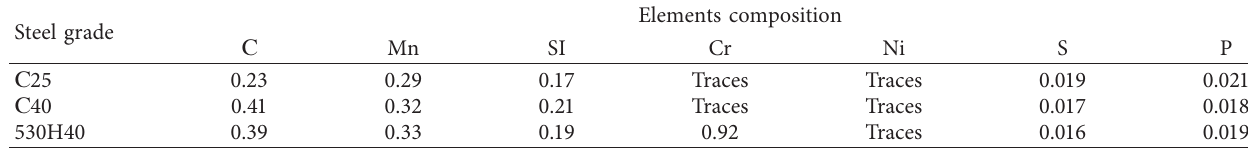
Table 3: The chemical composition of the investigated steels.